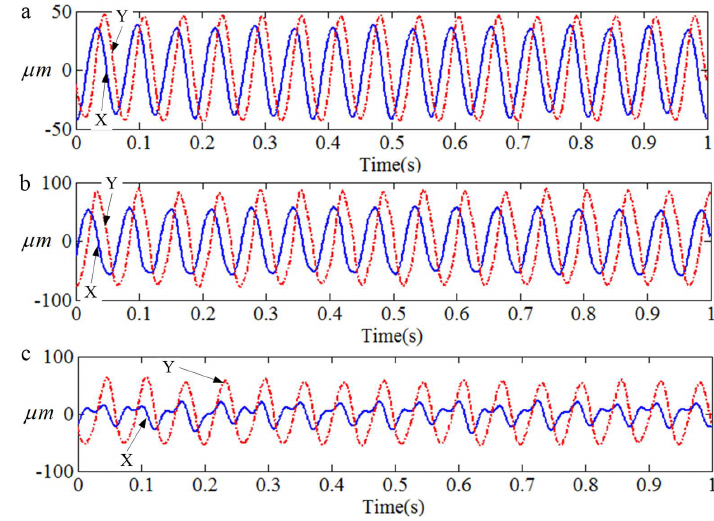
Figure 23. The vibration displacement signals under different running conditions. ( a ) Normal; ( b ) Rubbing; ( c ) Misalignment.